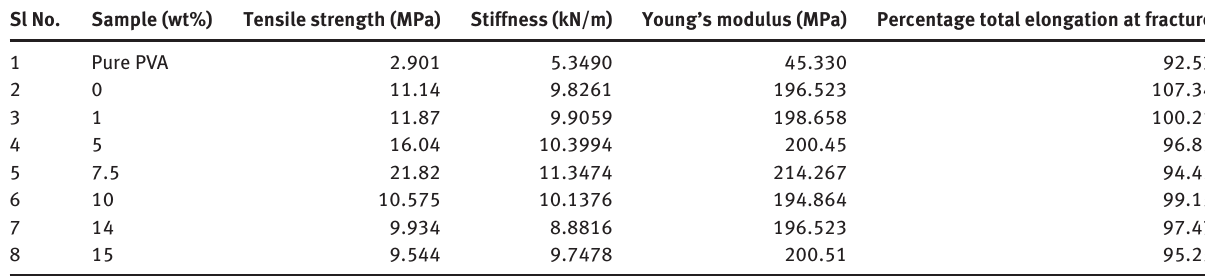
Table 3: Tensile properties of pure and doped PVA films. Sl No.